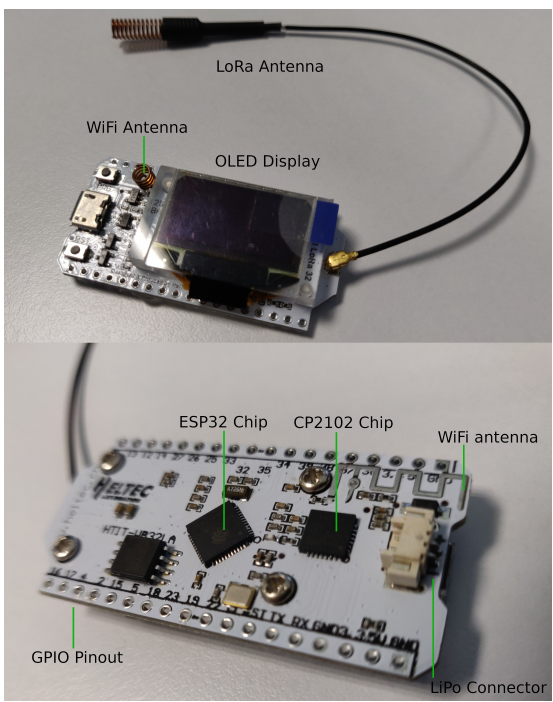
Figure 16. Components of the 433 MHz LoRa node. Table 7. Specifications of the 433 MHz IoT